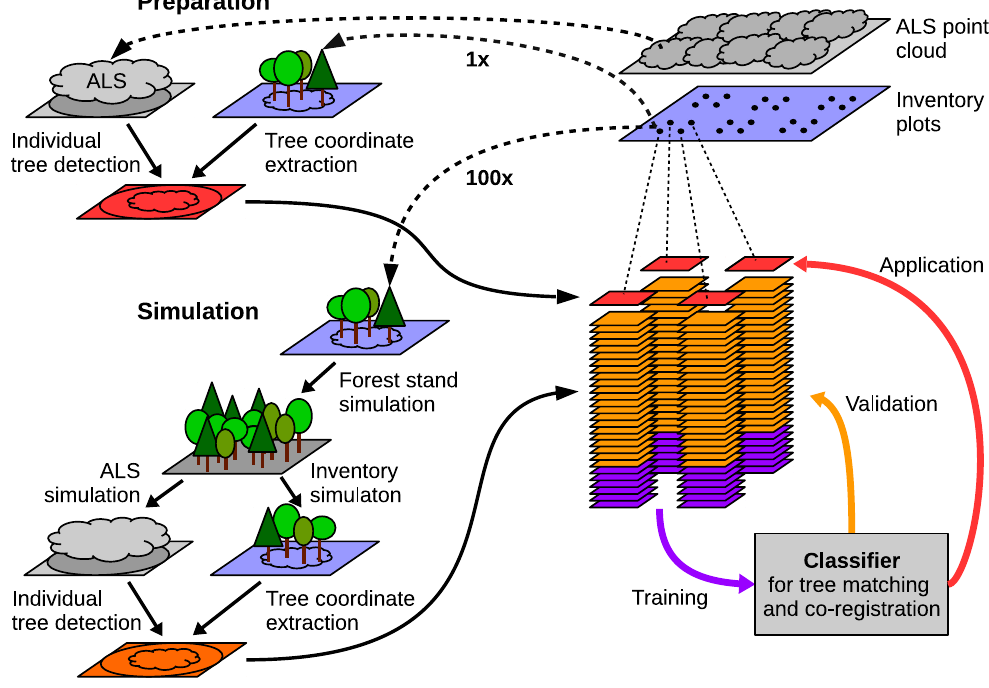
Figure 2. Study design. For each inventory plot, 100 simulations are generated which serve for algorithm training and validation. Finally, the algorithm is applied to the original inventory plots. ALS: airborne laser